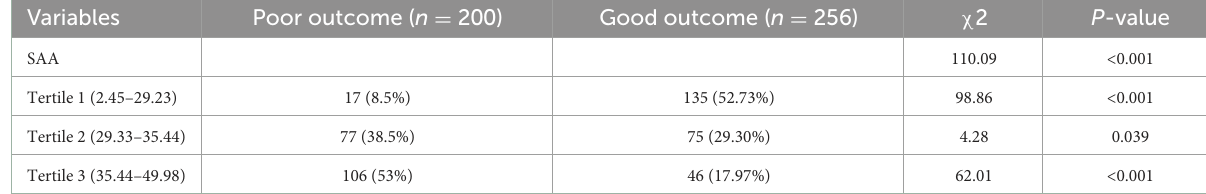
TABLE 3 SAA tertiles of patients.